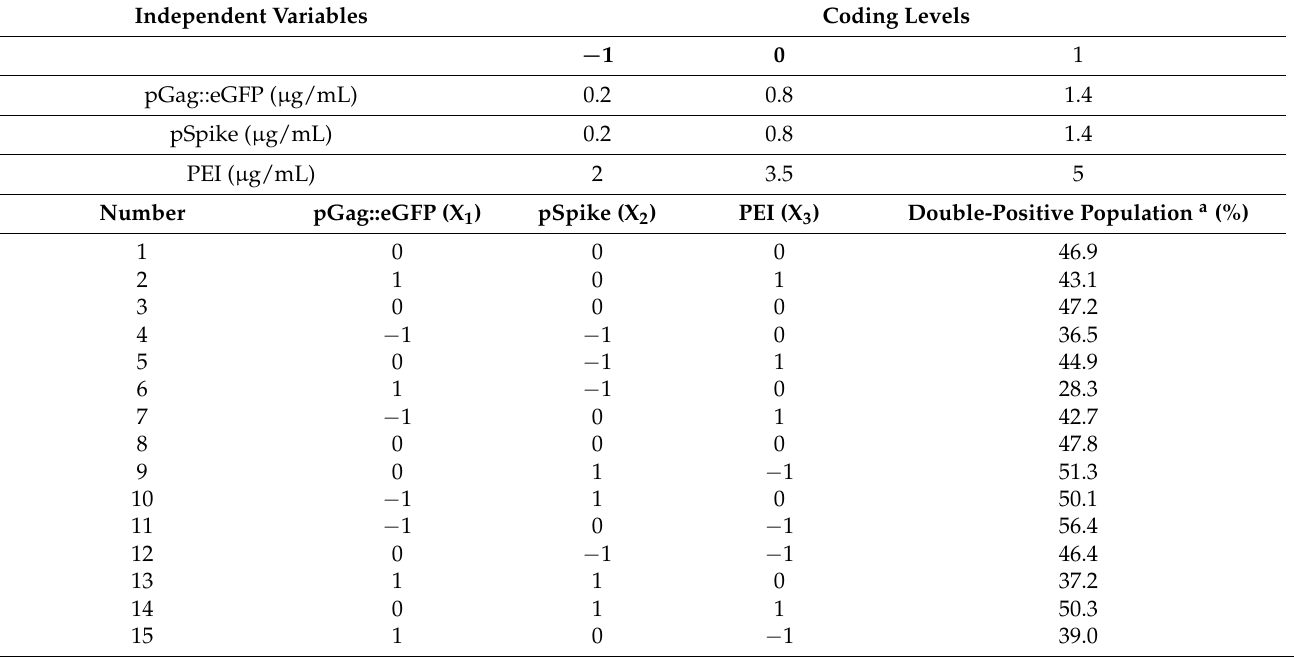
Table 1. Box–Behnken experimental design: code levels, matrix design, response and regression coefficients. Independent